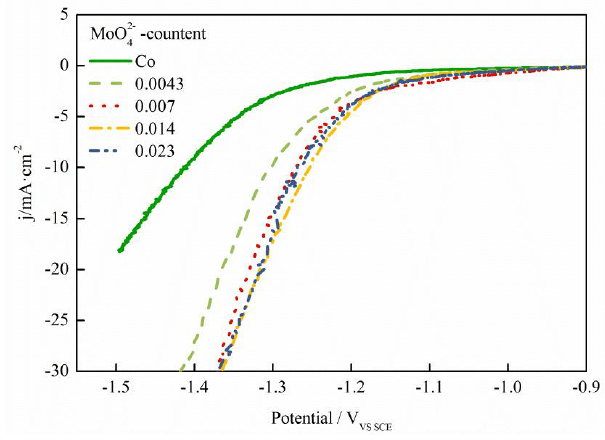
Figure 2. Linear sweep voltammograms of Co and Co-Mo electrodeposition in different electrolytes.